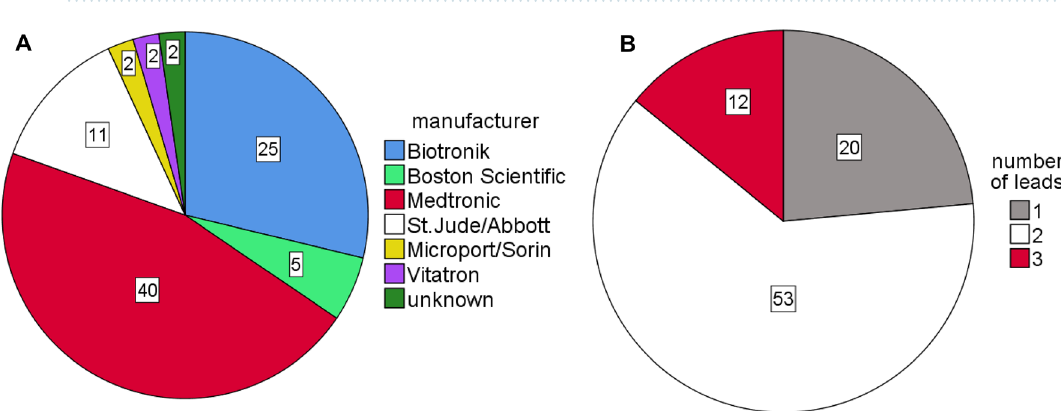
Figure 2. Pie charts illustrating the composition of the CIED cohort. ( A ): CIED manufacturers are depicted. In 2 CIED total battery depletion disabled interrogation. CIED type and manufacturer were not recorded. ( B ): CIED analysed were predominantly dual chamber devices. Devices for cardiac resynchronisation therapy (with 3 leads) played a minor